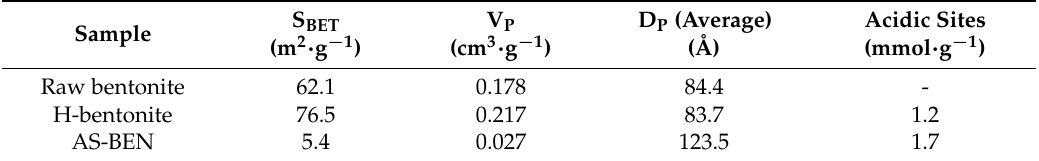
Table 1. Textural parameters and chemical properties of samples.